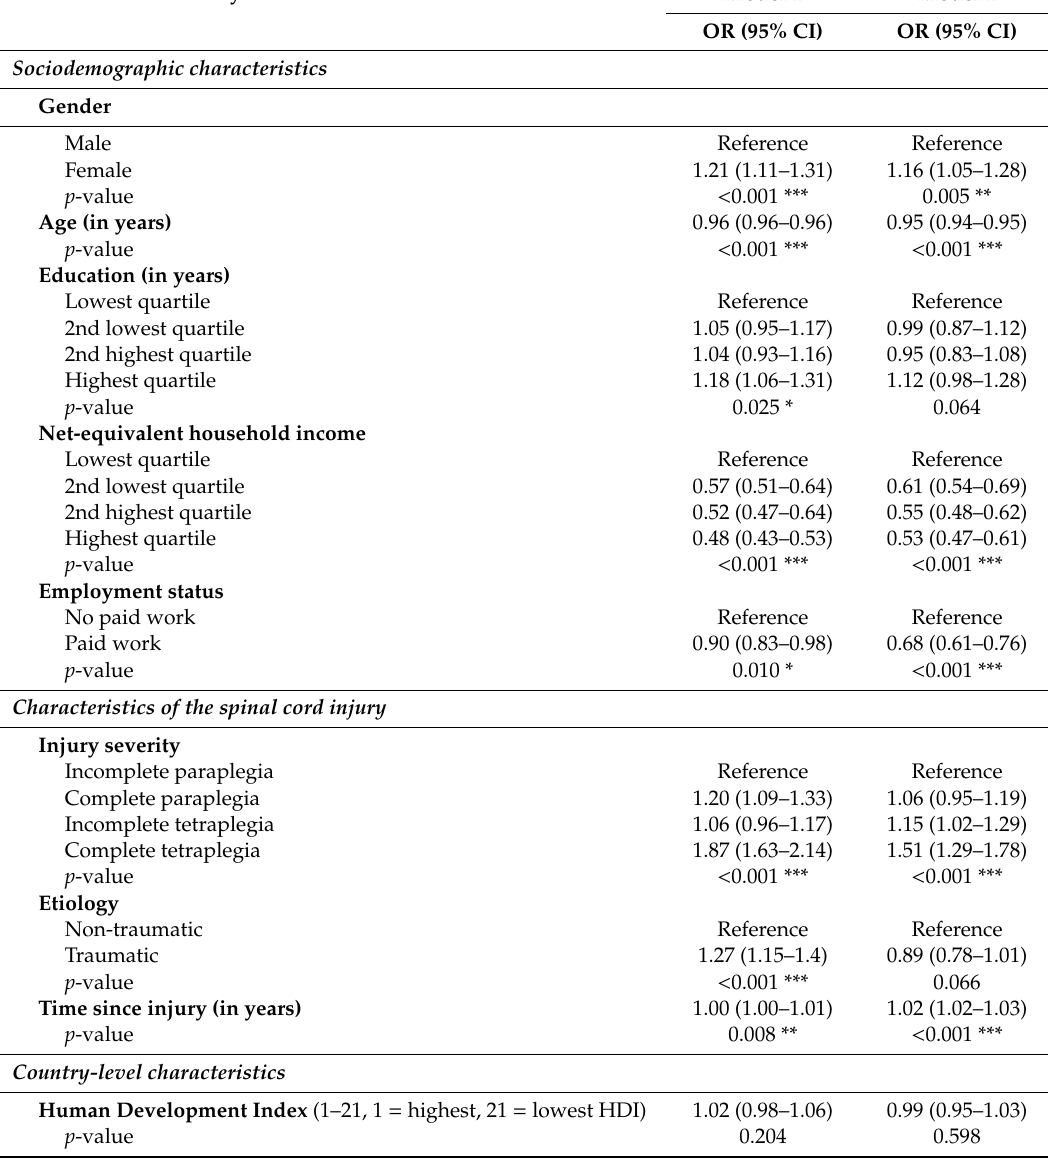
Individual and Country-level